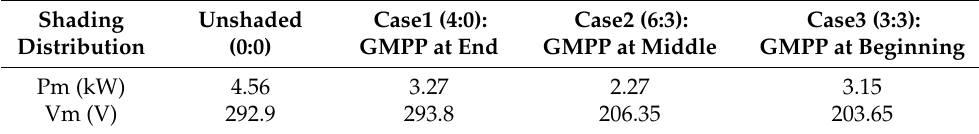
Table 2. The maximum power point under different shadow distribution cases.